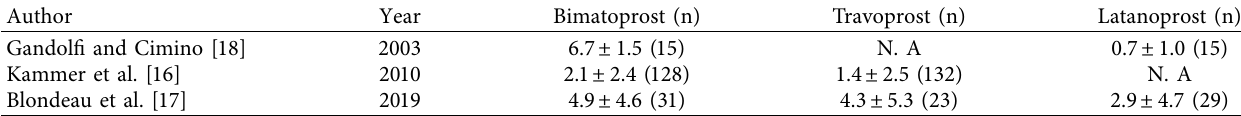
Table 7: Reduction of IOP from baseline of PGAs in LNRs.